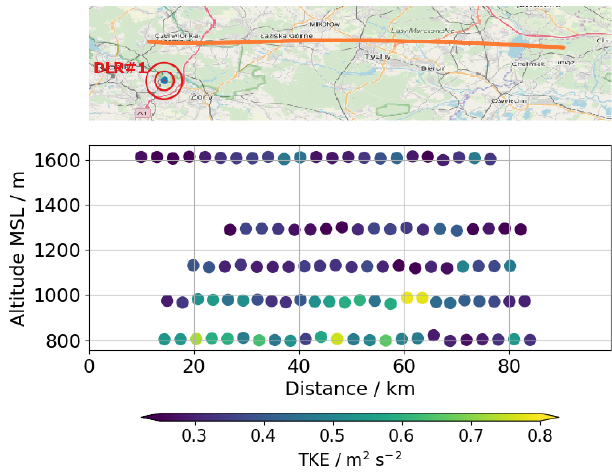
Figure 11. D-FDLR TKE measurements at five flight levels.